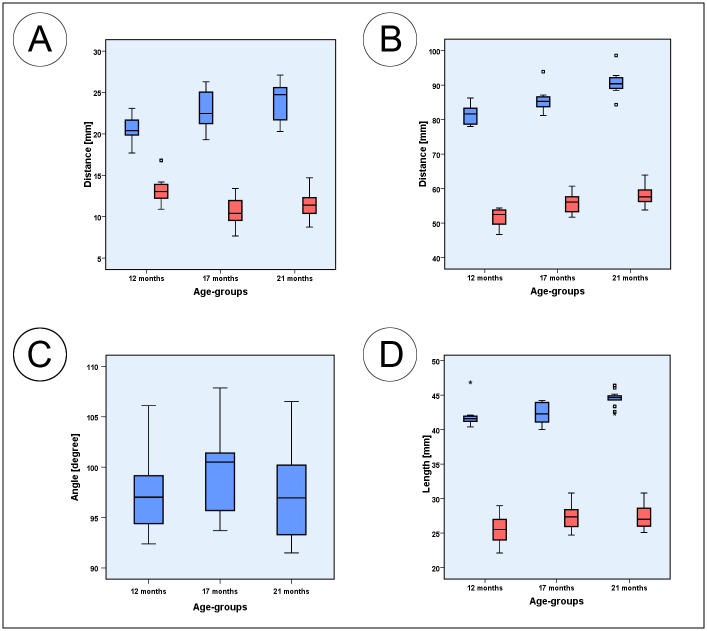
Box plots of measured parameters.(A) Box plots of mental foramen to inferior mandible border height (blue), and mental foramen to mandibular alveolar crest height (red); (B) mental foramen to gonion length (blue) and interforaminal breadth (red). (C) Box plots of the gonial angle measurements (blue); (D) Box plots of the mandibular ramus length (blue) and superior ramus length (red). Squares associated with the box plots are individual outliers. Outliers that are marked with asterisks are values that exceed the triple interquartile range.